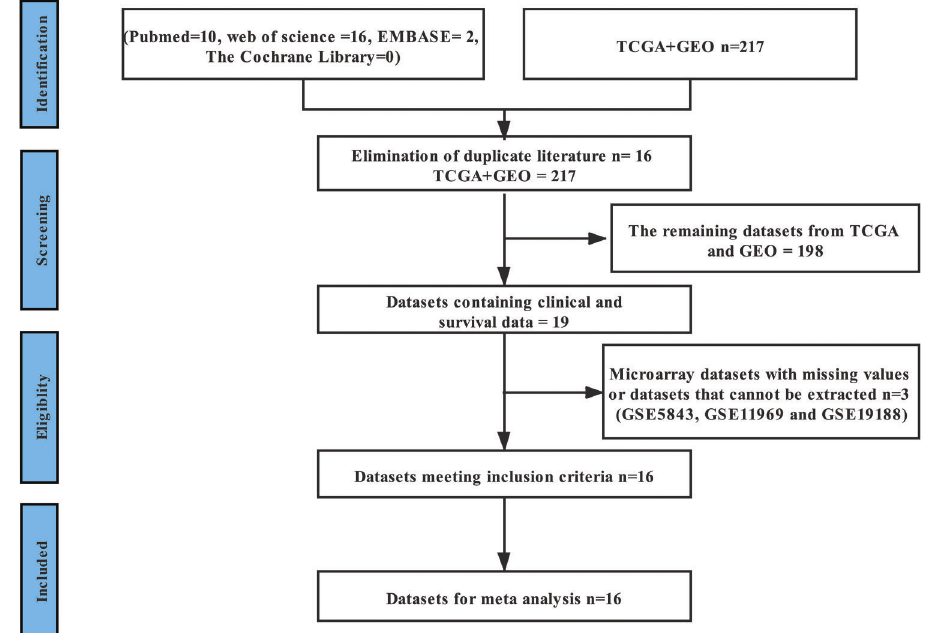
Figure 1 - The general screening process for inclusion in the